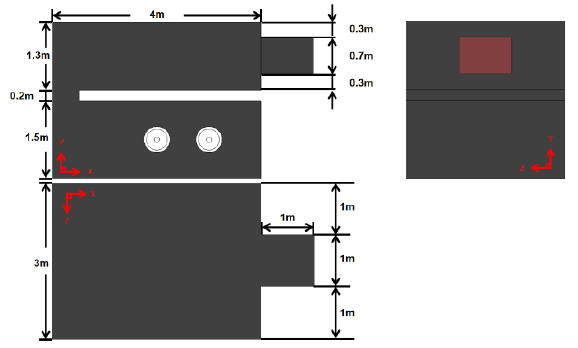
Figure 2. Three views of landfill leachate concentrate incinerator.